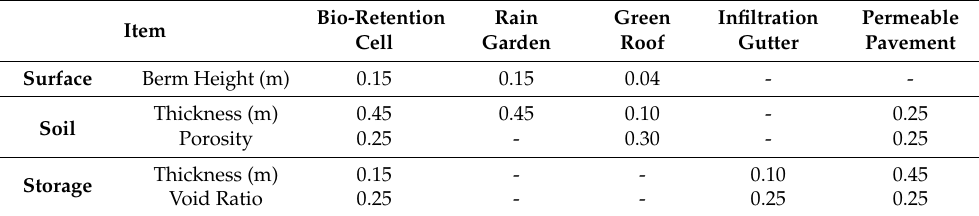
Table 11. Parameters for LID facilities.